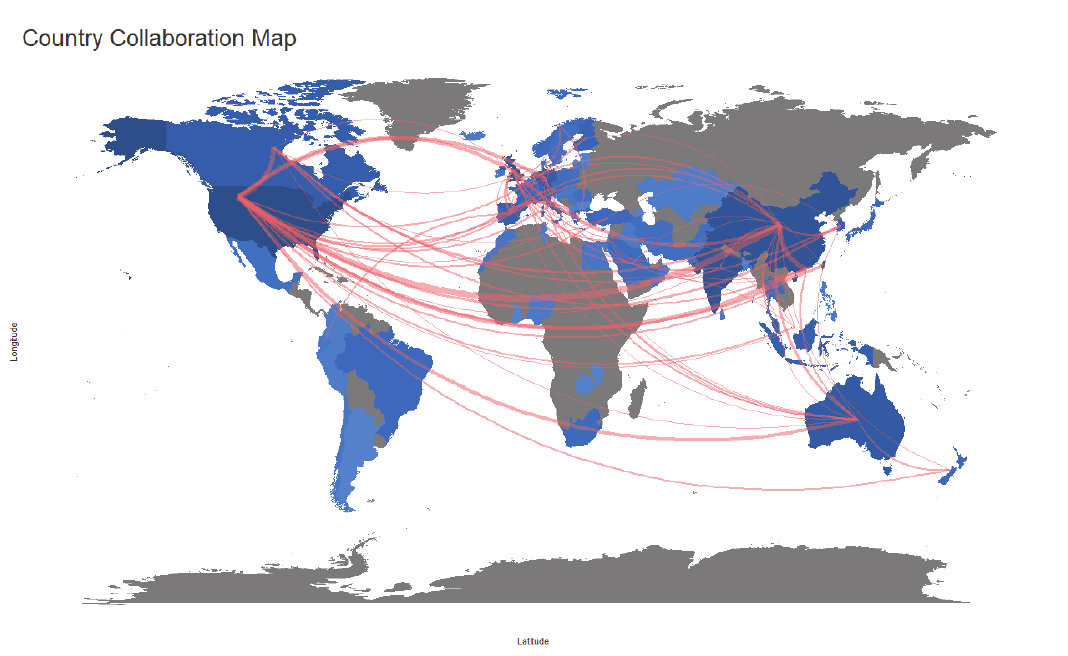
Fig. 9. Country collaboration